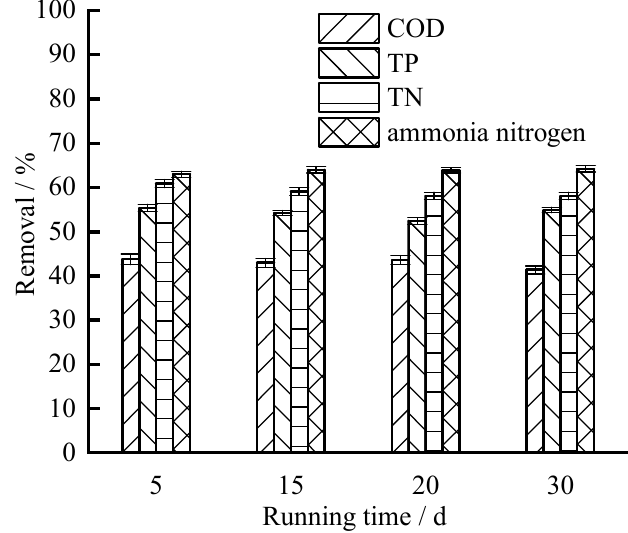
Figure 2. Removals of Conventional pollutants.